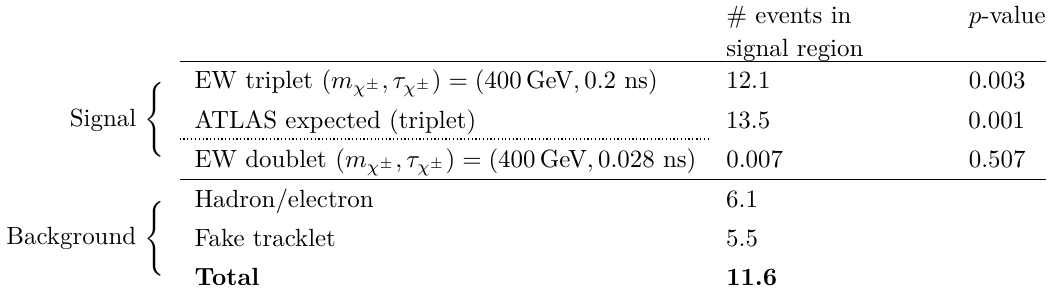
, τ ) = (400 GeV , 0 . 028 ns) and backgrounds by χ ± χ ± # events in